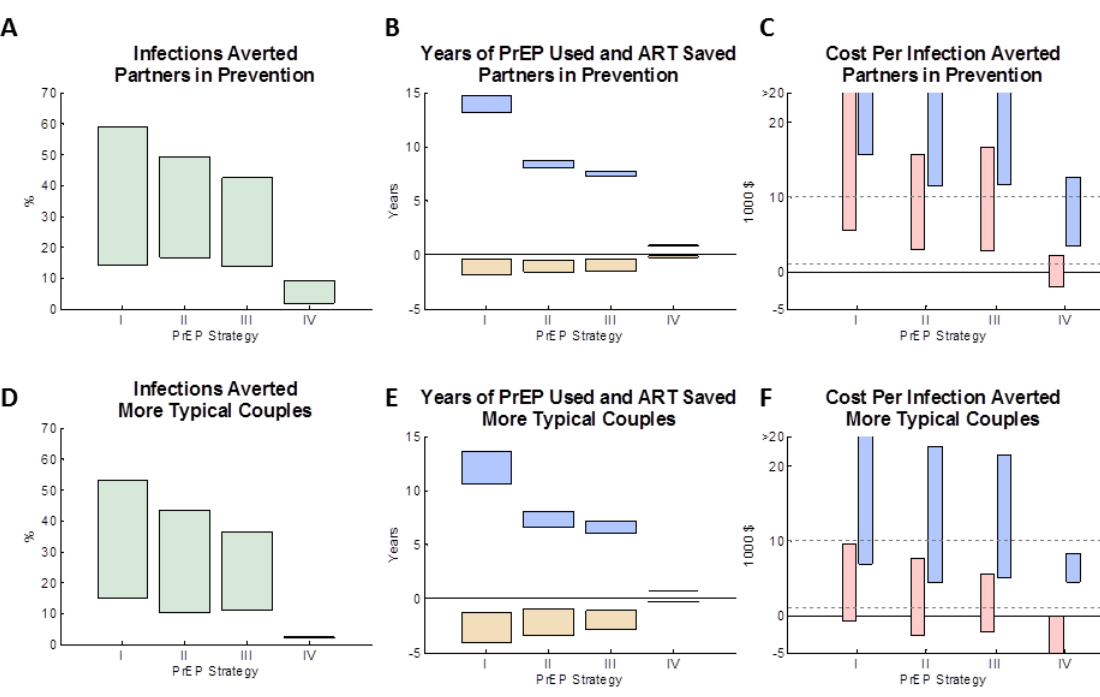
Figure 1. The impact of different PrEP interventions on HIV infections in the couple. (A, D) The proportion of infections averted by age 50 (relative to a baseline strategy with no PrEP intervention) for four PrEP strategies (see Table 2). (B, E) The expected mean years on PrEP (blue boxes) and years on ART averted (yellow boxes) for each of the four PrEP interventions (after discounting). (C, F) The expected cost per infection averted for each of the four PrEP interventions: the pink boxes reflect the lower PrEP cost estimates (and the higher ART cost estimates) and the blue boxes reflect the higher PrEP cost estimates (and the lower of ART cost estimates). In (A–F), the boxes shows a ‘‘feasible’’ range of results, which corresponds to a functional effectiveness of PrEP ranging between 50% and 80%. The assumptions used about the couple’s behaviour are: (A–C) ‘‘partners in prevention’’ assumptions and (D–F) the ‘‘more typical couples’’ assumptions (see main text for details). Figure S2 shows the analysis repeated for alternative types of couples. (Summary of strategies from Table 2: I, always PrEP; II, PrEP prior to ART with 1-y overlap; III, PrEP prior to ART (no overlap); IV, PrEP during conception/pregnancy.)